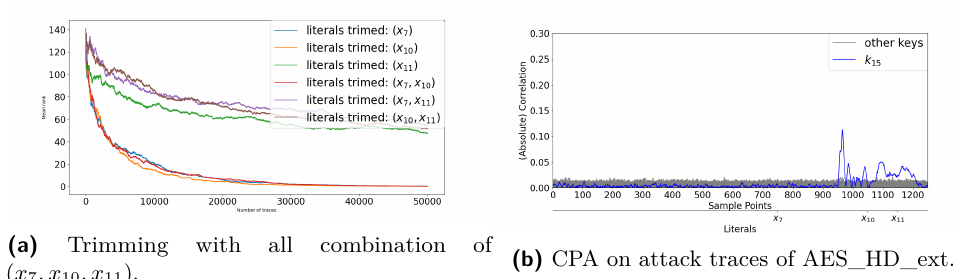
Figure 19: Guessing entropy after trimming and CPA of